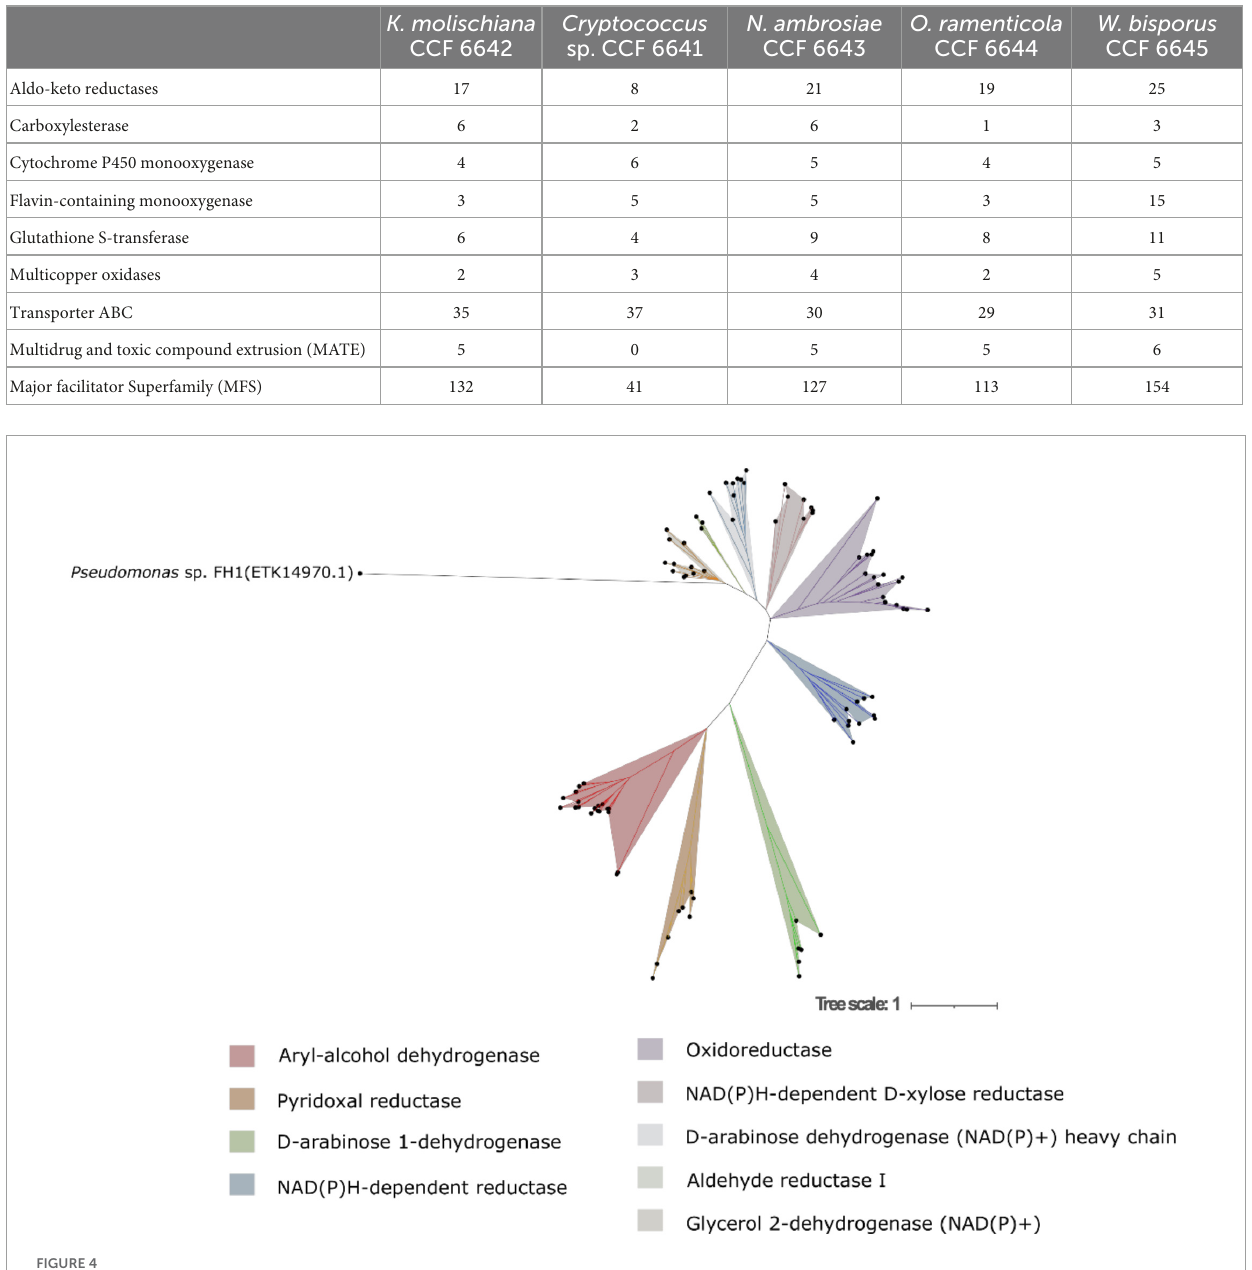
FIGURE4 Maximum-likelihood tree of aldo-keto reductases predicted from all five yeast